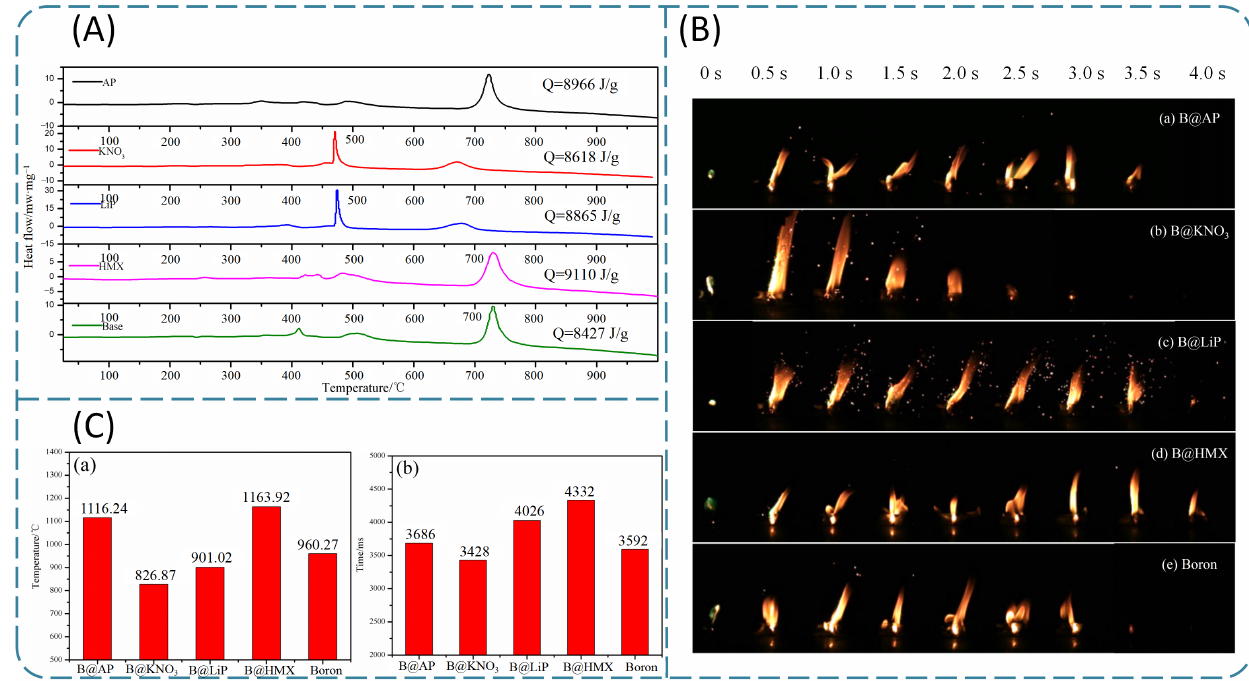
Figure 6. ( A ) The DSC curves and ( B ) combustion flame images of different samples; ( C ) combustion characteristics of ( a ) average combustion temperature and ( b ) average self-sustaining combustion time in the laser ignition experiment [76].